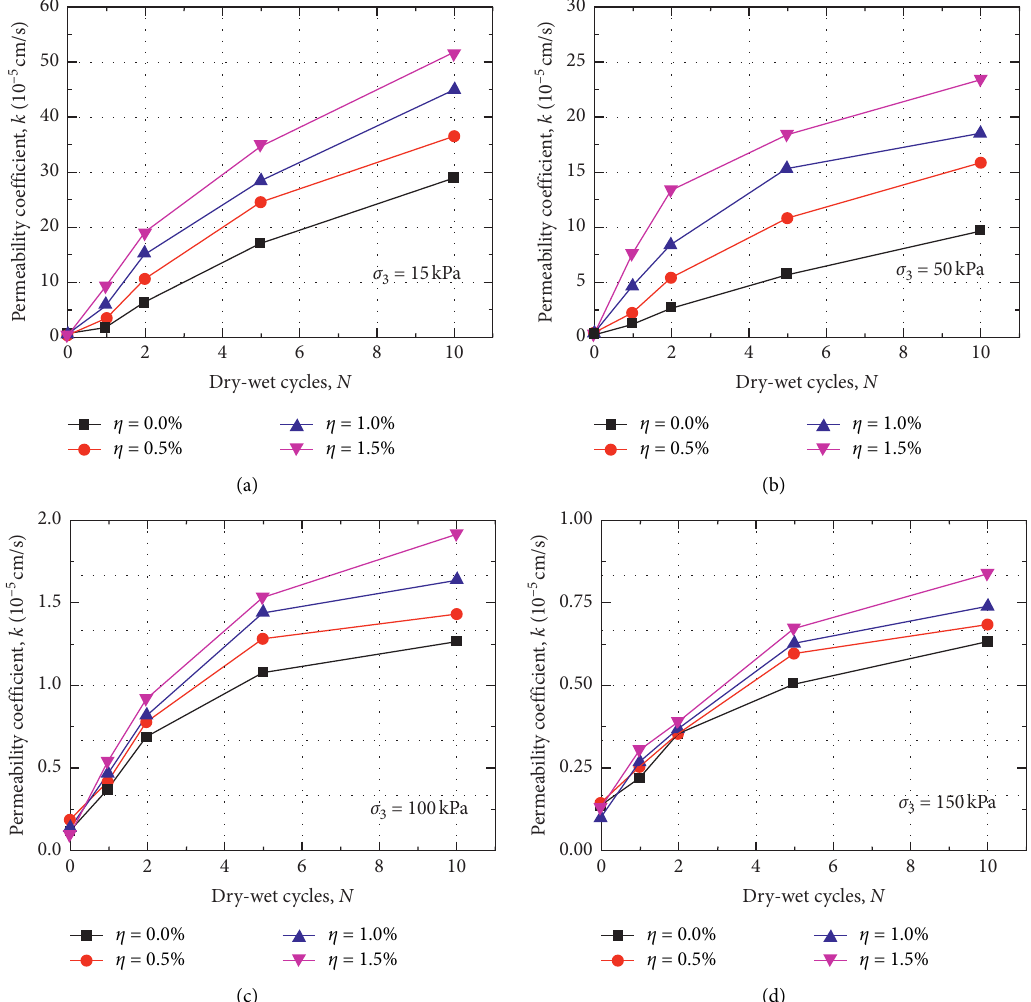
Figure 3: Permeability coefficient of saline intact loess after dry-wet cycles. (a) σ